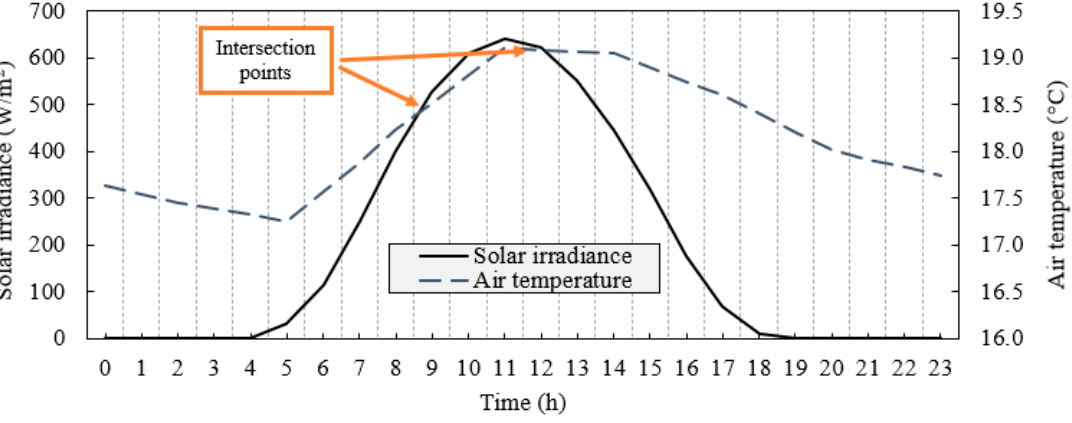
Figure 4. Solar irradiance/air temperature curves over time [35] (adapted from [12]).